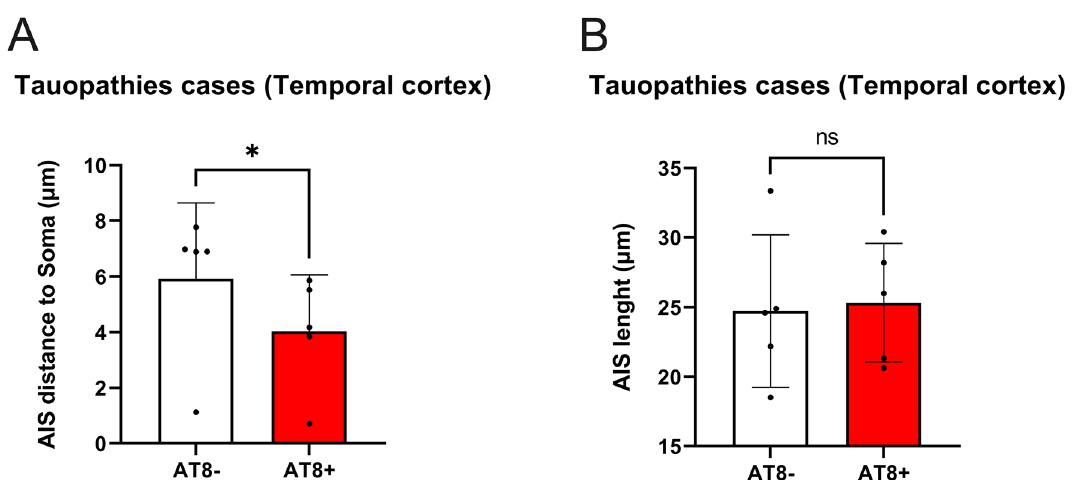
Figure 2. Trios of confocal stack Z projection microphotographs taken from AT8 (red)/βIV-Spectrin (green)/ NeuN (blue) triple-immunostained sections from the temporal neocortex of an AD patient (IF13, A − C ) and from a non-demented case (AB1, D − F ). Arrowheads and arrows indicate the start point and the end point, respectively, of AISs labeled by βIV-Spectrin immunostaining. Asterisks indicate neurons containing neurofibrillary tangles. Scale bar shown in D indicates 11 µm in A − F . Adobe Photoshop CS4 (Adobe Inc., 2019) software was used to compose figures.